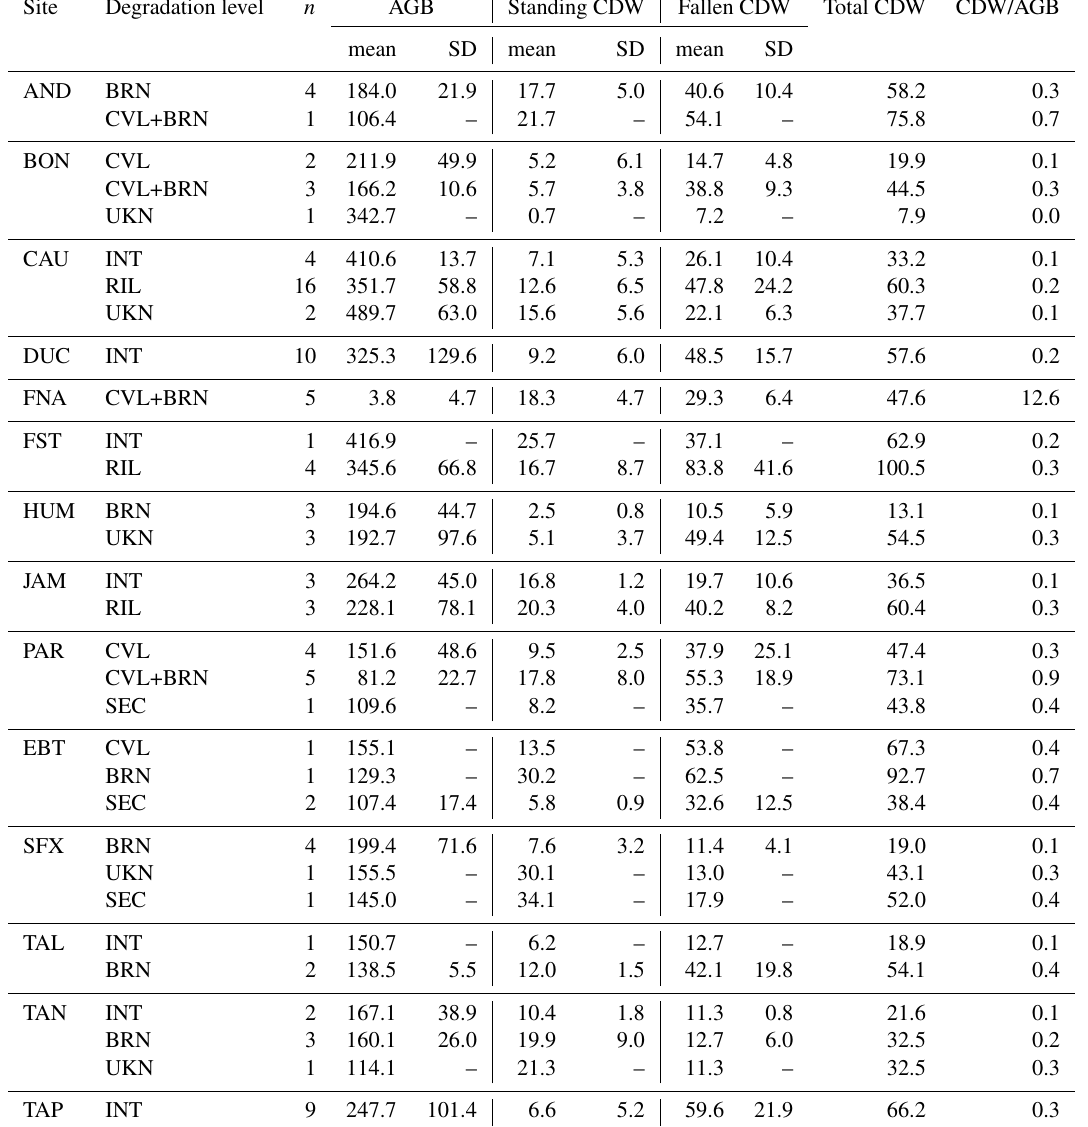
Table 3. CDW (mean and standard deviation) by degradation level and site. AGB, standing CDW, fallen CDW, and total CDW are inMgha − 1 . Site Degradation level n AGB Standing CDW Fallen CDW mean SD mean SD AND BRN 4 BON